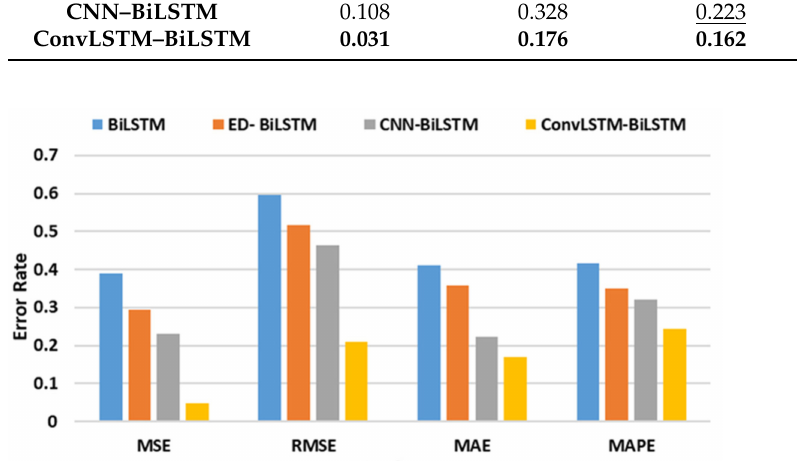
Figure 6. Average resolution-based error rate obtained using cross-validation method based on Household